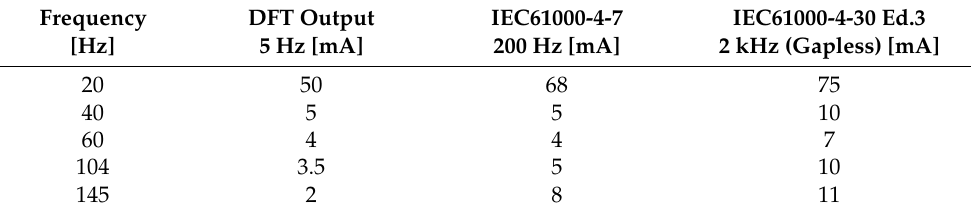
Table 3. Comparison of supraharmonic measurement methods by Peak value [14].